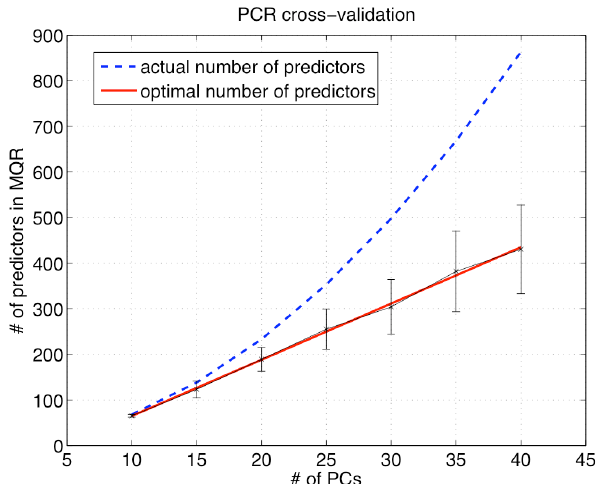
Figure 9. The results of PCR cross-validation for the main level of our quadratic SLW-only models. The number on the abscissa shows how many SLW PCs are included in the model. The dashed line denotes the total number of predictors in the equation for each PC. The error bar plot (light solid line) shows the optimal number of PCR components, with the central value being the average of this number over its individual estimates obtained for each PC equation, and the bar representing the standard deviation of these estimates. The straight heavy line is the optimal linear fit of the dependence of the PCR-optimized number of components on the number of original variables (PCs) considered.